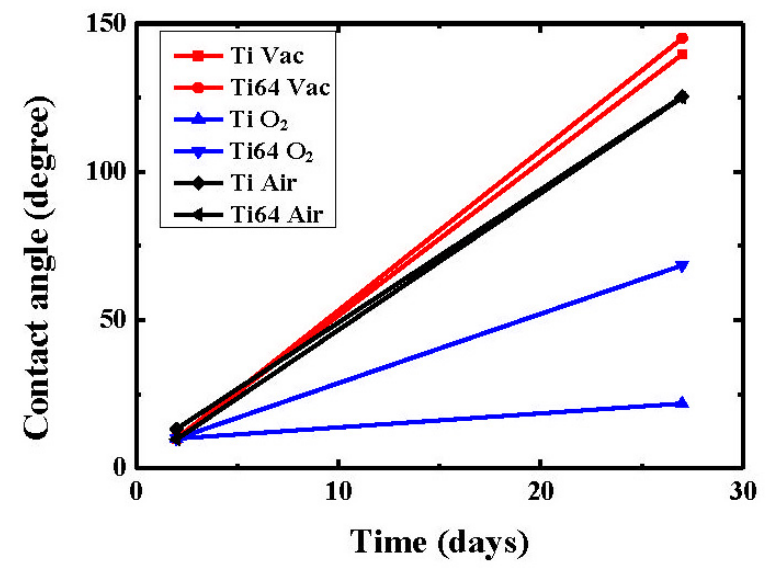
Figure 10. The contact angle versus the holding time (in days) for the N0 samples of CP-Ti and Ti64 measured separately in vacuum and oxygen